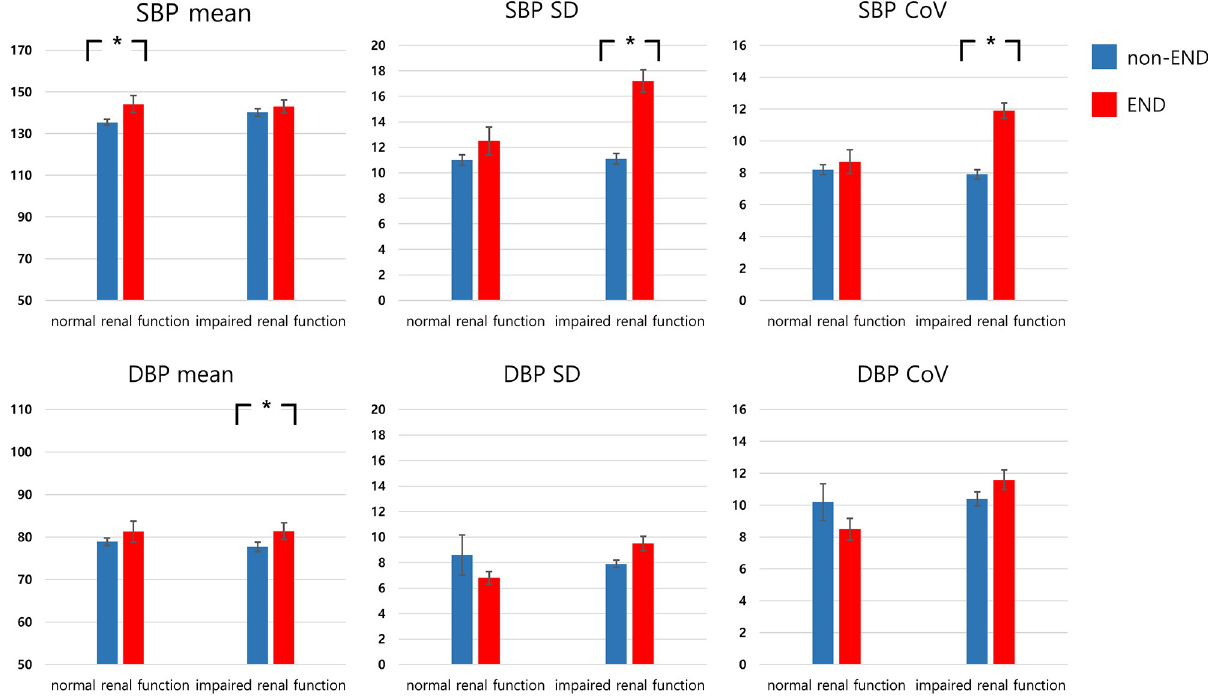
Fig 2. Comparison of BPV parameters according to the presence of END and renal function. BPV, blood pressure variability; END, early neurological deterioration; SBP, systolic blood pressure; DBP, diastolic blood pressure; SD, standard deviation; CoV, coefficient of variation. � Statistical significance: P < 0.05.